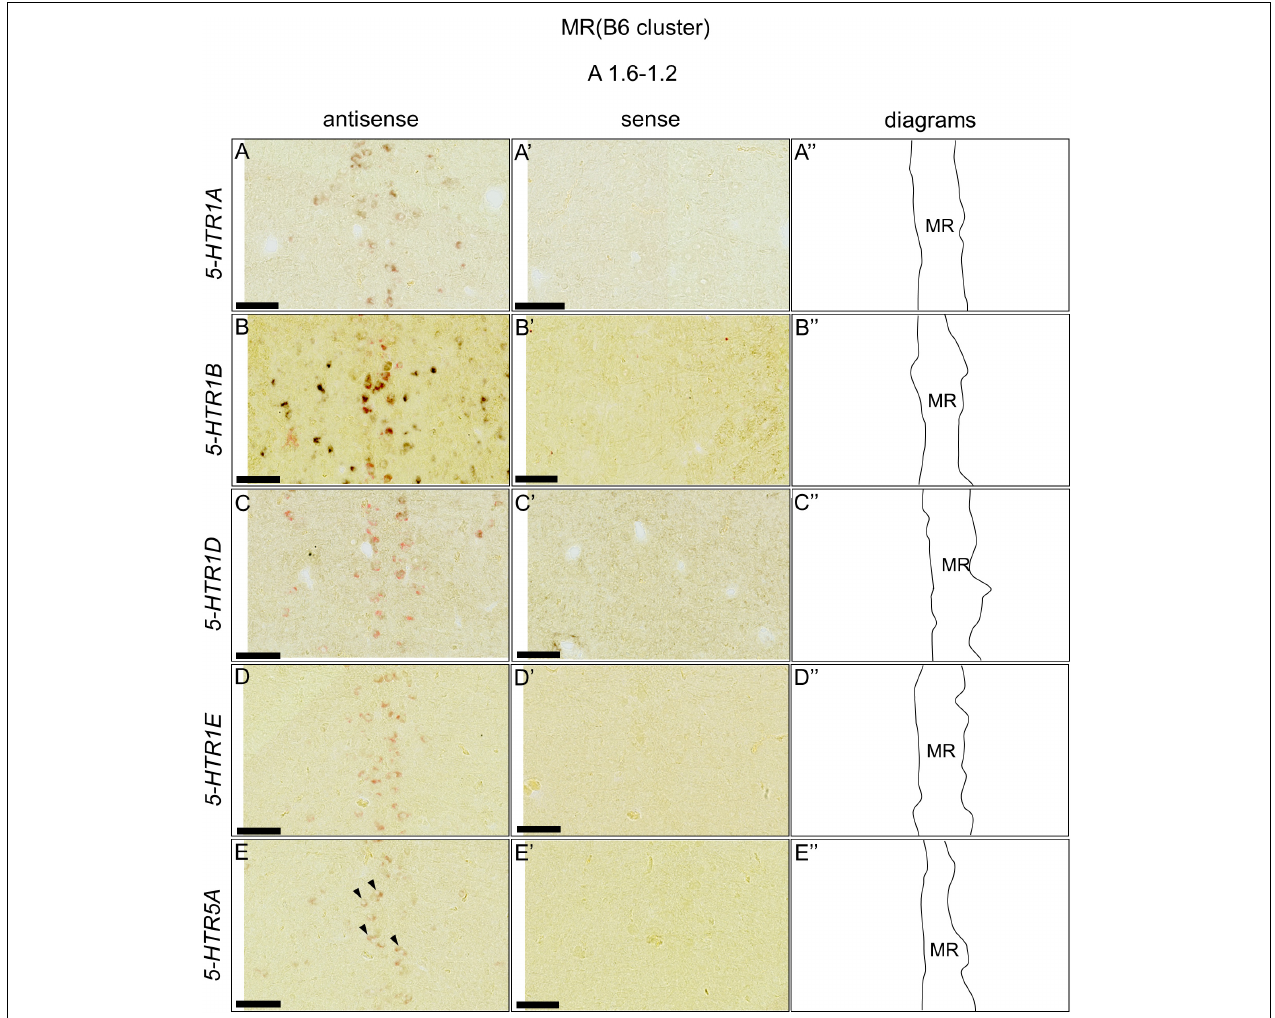
FIGURE 9 | Double in situ hybridization of 5-HTRs and TPH2 in the MR (B6) of the P1 chick brainstems. Digoxigenin-labeled ( 5-HTRs ) and fluorescein-labeled TPH2 RNA antisense (A–E) and sense (A’–E’) probes were used for double in situ hybridization in coronal sections of P1 chick brains. (A”–E”) Diagrams of coronal sections are shown in the rightmost panels. Arrowheads indicate signals. MR, median raphe; P1, post-hatch day 1. Scale bars = 100 µ